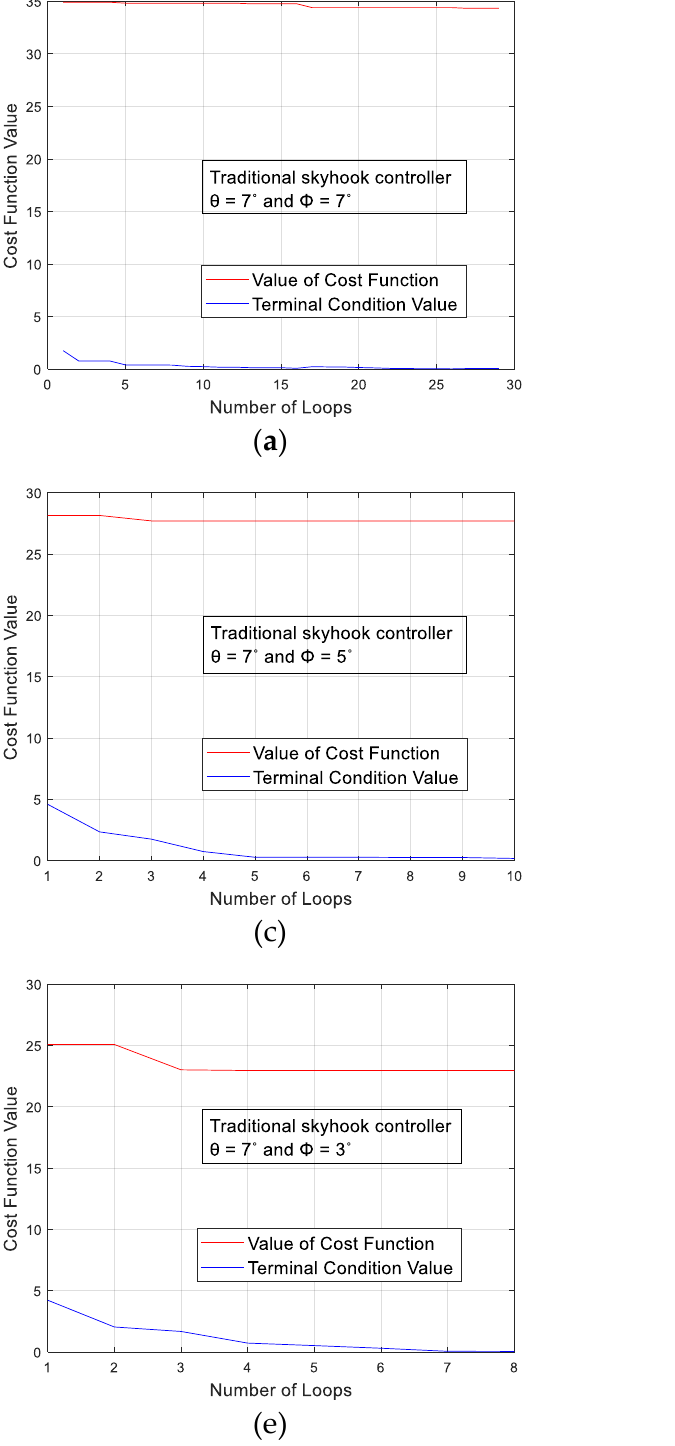
Figure 11. Simulation results of the Nelder – Mead simplex method in the case of ( a , b ) θ = 7 ° and Φ = 7 °; ( c , d ) θ = 7 ° and Φ = 5°; ( e , f ) θ = 7 ° and Φ = 3 °. ( a , c , e ) Traditional skyhook controller; ( b , d , f ) Skyhook extended controller.